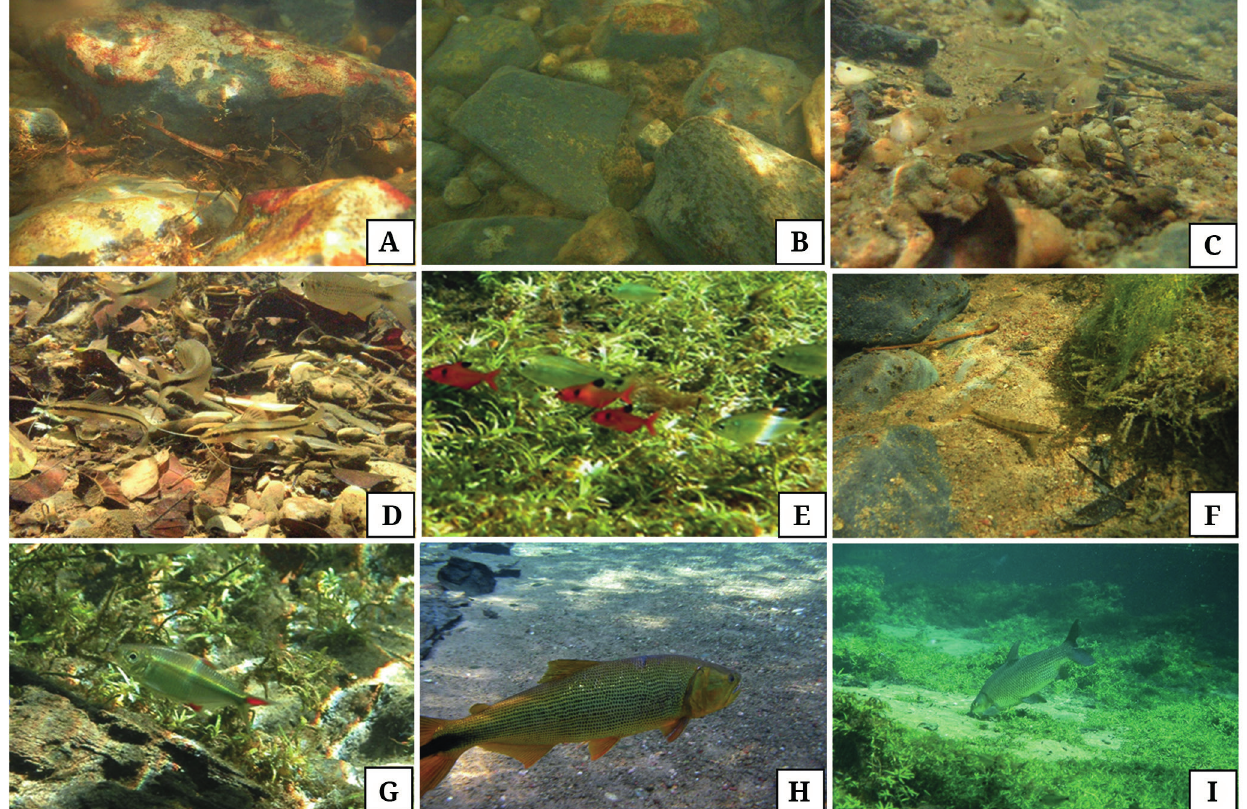
FIGURE 3 | Representative images of the fish assemblage from Serra da Bodoquena streams. A. Farlowella paraguayensis among twigs and leaf litter in the substrate; B. Hypostomus froehlichi between boulders; C. Creagrutus meridionalis foraging near a sandy substrate; D. Pimelodella taenioptera and Astyanax lacustris foraging among leaf litter in the substrate; E. Hyphessobrycon eques and Jupiaba acanthogaster using marginal vegetation; F. Characidium zebra using the sit-and-wait tactics on the sandy substrate; G. Psalidodon marionae foraging near the rocky substrate; H. Salminus brasiliensis swimming in the water column; I. Prochilodus lineatus foraging near patches of vegetation. Photos: Renato M. Romero and Fabrício B.